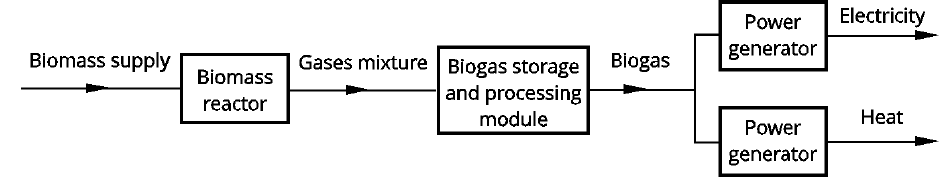
Figure 6. Schematic diagram of the biogas system.